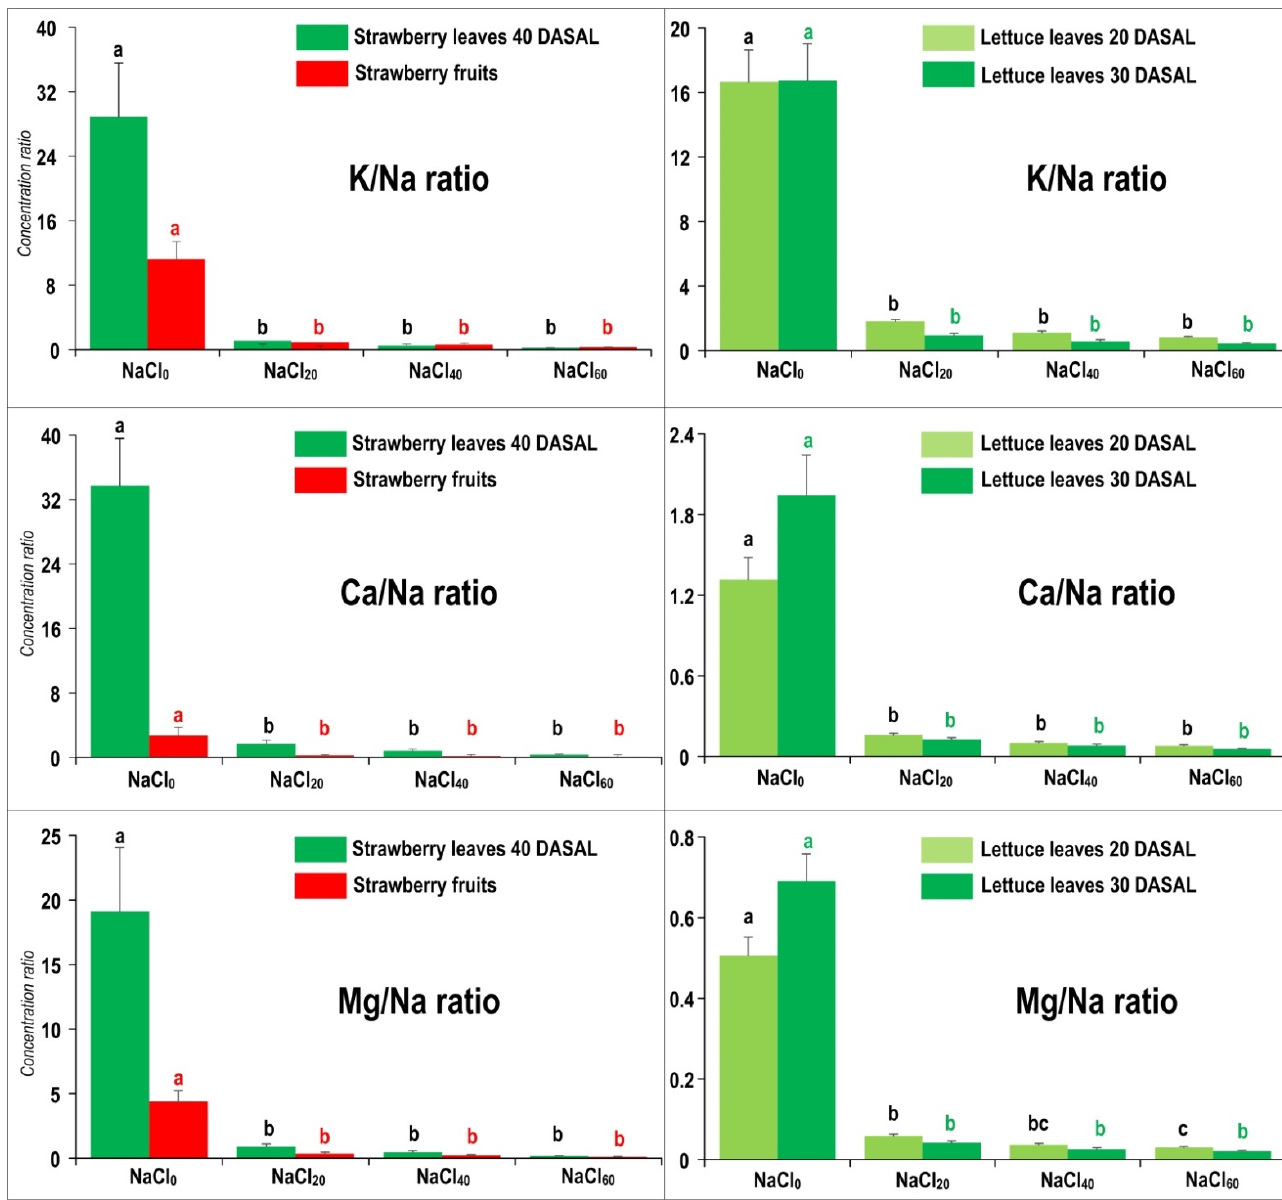
Figure 2. Impact of applied treatments on elemental ratios in lettuce leaves 20 and 30 days after salinity (DASAL) treatment commenced, and strawberry leaves (40 DASAL) and fruits. Bars (means + SE, n = 4) with the same letter and colour in each graph are not significantly different among the treatments, according to Tukey’s HSD test.